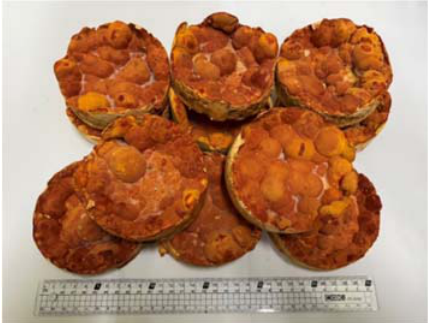
Figure 1. Disc ‐ cultured Antrodia cinnamomea fruiting bodies obtained from 90 days of